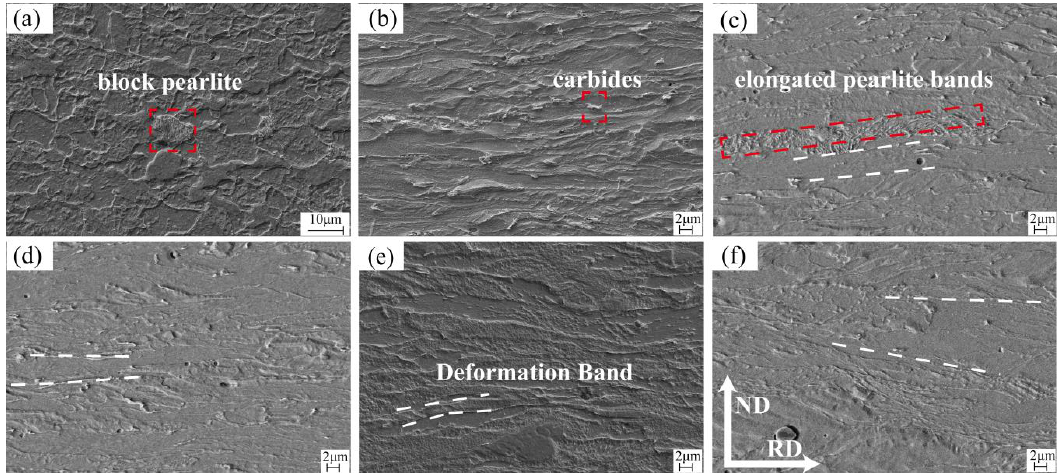
Figure 2. The hot rolling, room temperature, and warm rolling specimen microstructures. ( a ) Hot rolling: block pearlite; ( b ) room temperature rolling: carbides; ( c ) 250 °C: elongated pearlite bands; ( d ) 350 °C: widened band; ( e ) 450 °C: refined deformation band; and ( f ) 550 °C: widened band again.